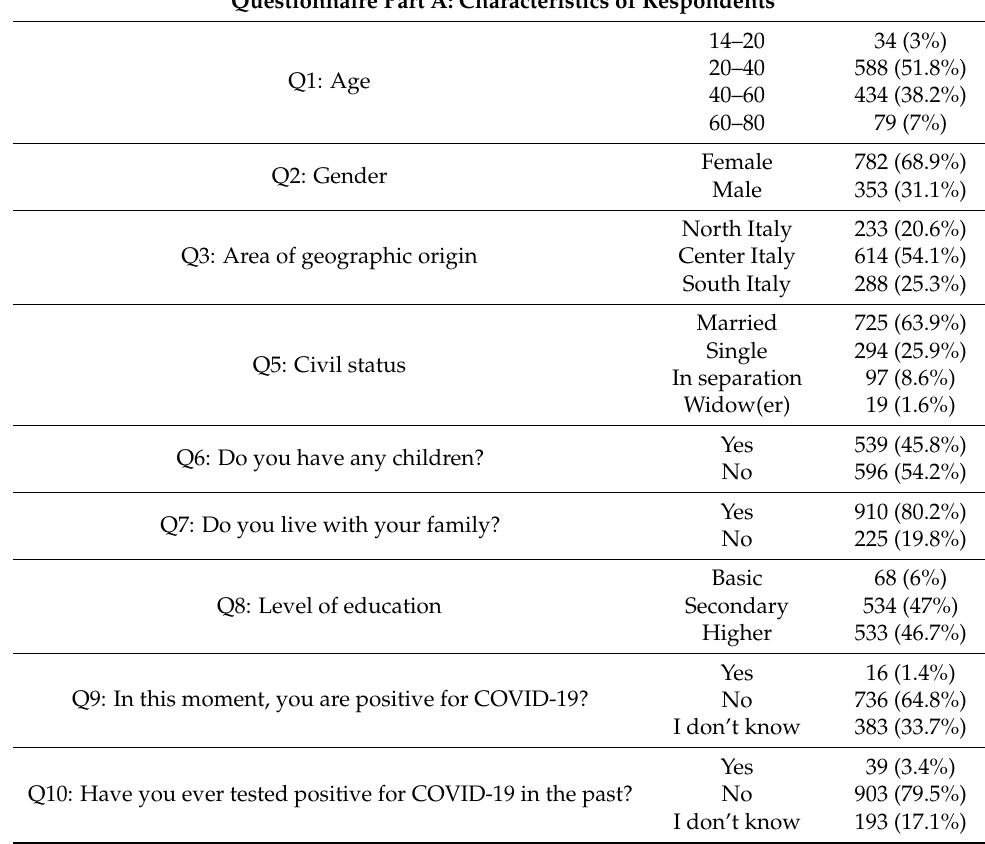
Table 1. Characteristics of the